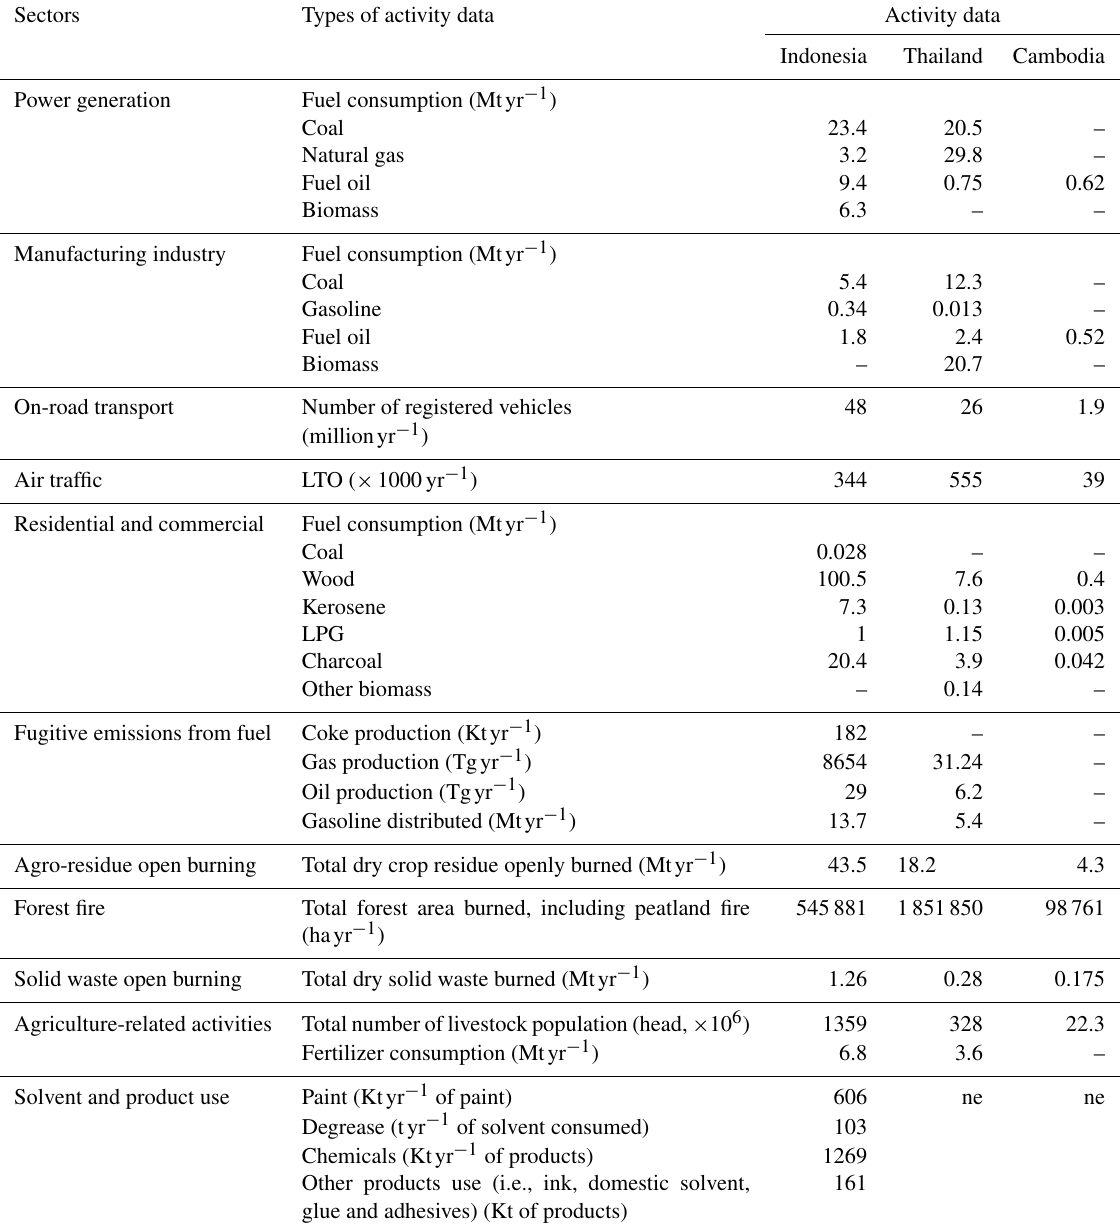
Table 1. Summary of activity data level from different emission sources in three countries.